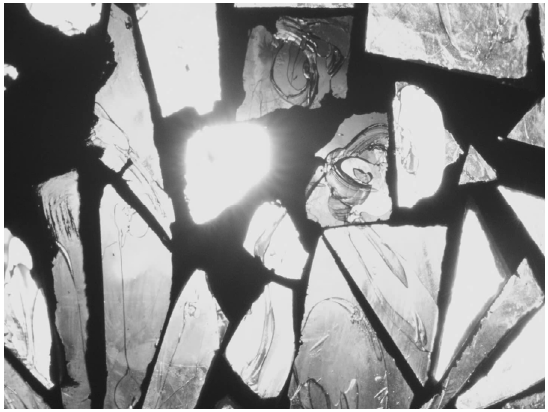
Figure 7. A prayer card used by Ida. Figure 8. The stained glass window. Figure 8. The stained glass